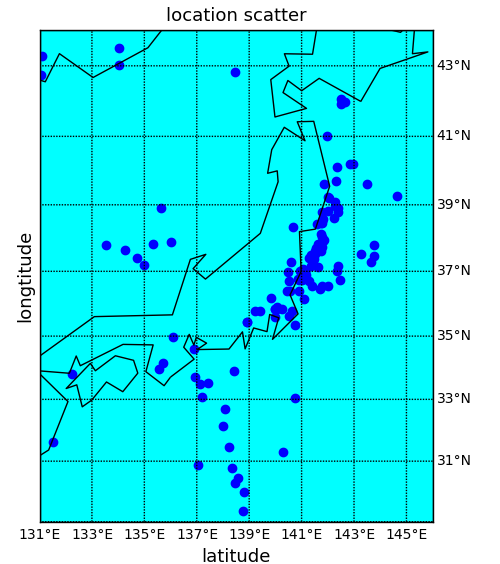
Figure 4. Map of the historical earthquake events recorded by KSRS array from 2011 to